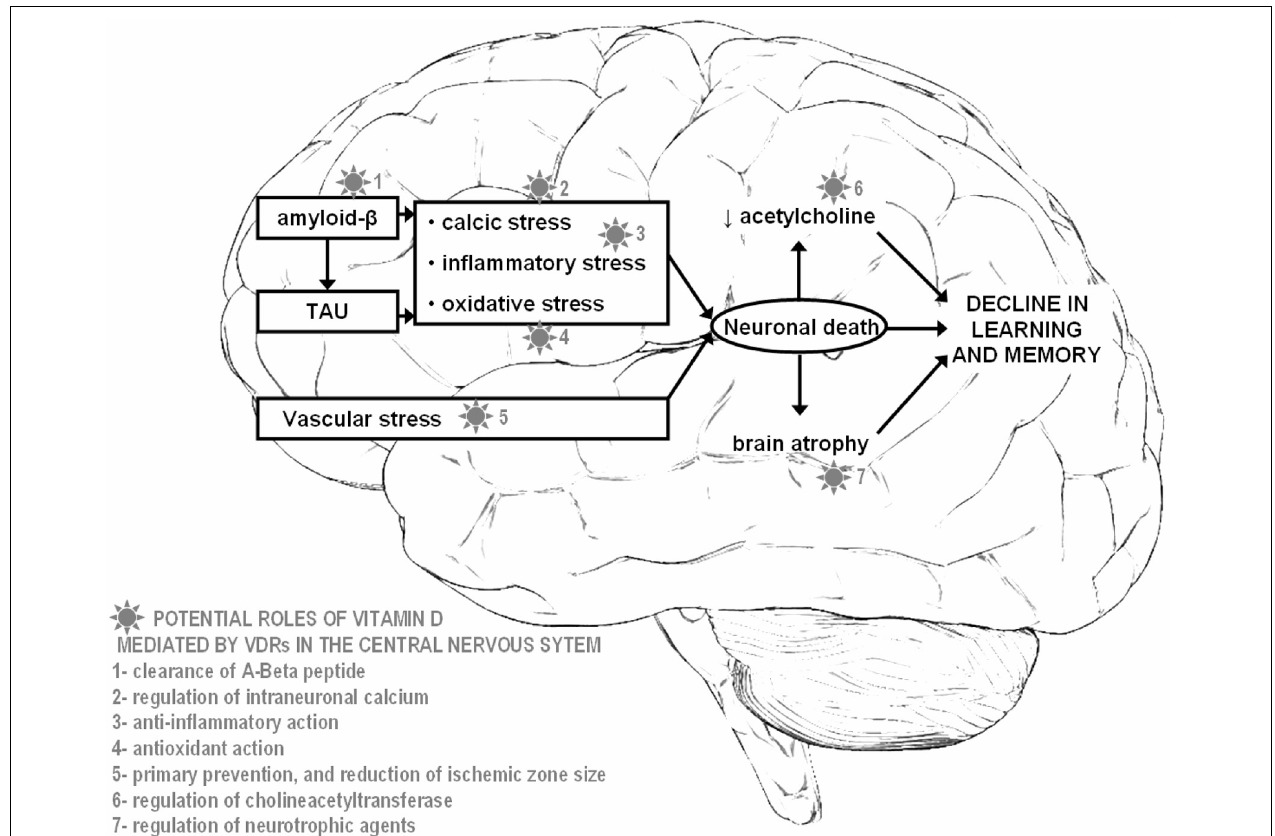
FIGURE 1 | Potential neuroprotective roles offered by vitamin D in Alzheimer disease.